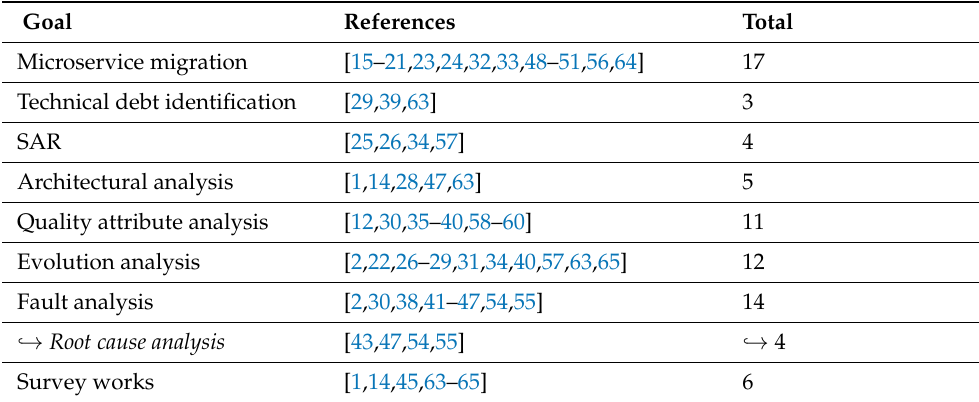
Table 6. Works relevant to RQ2.